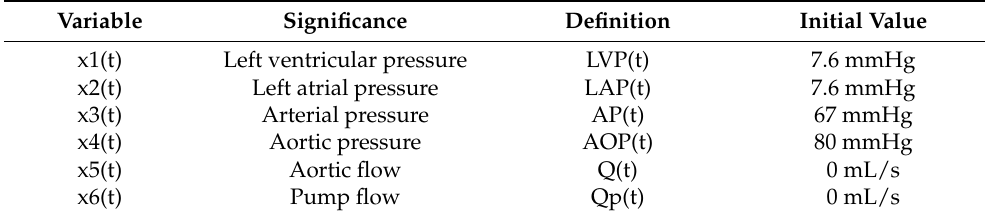
Table 2. State variables of the left ventricular circulation